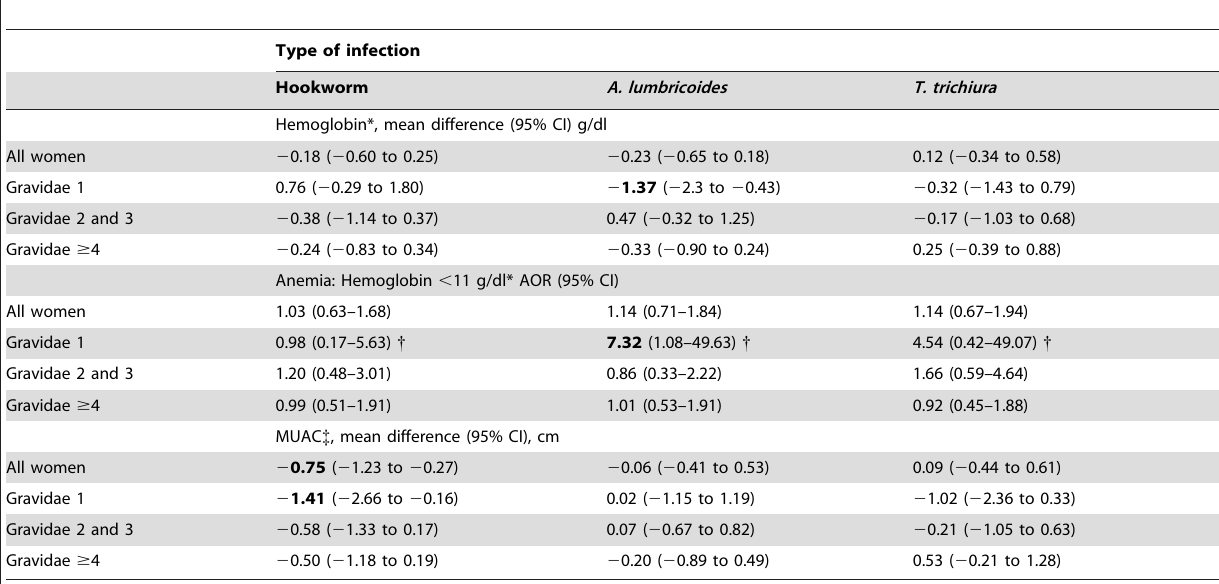
Table 2. Effects of geohelminth infections on hemoglobin, anemia, and mid upper arm circumference by type of infection and gravida group among pregnant women in Gem, July 2003.